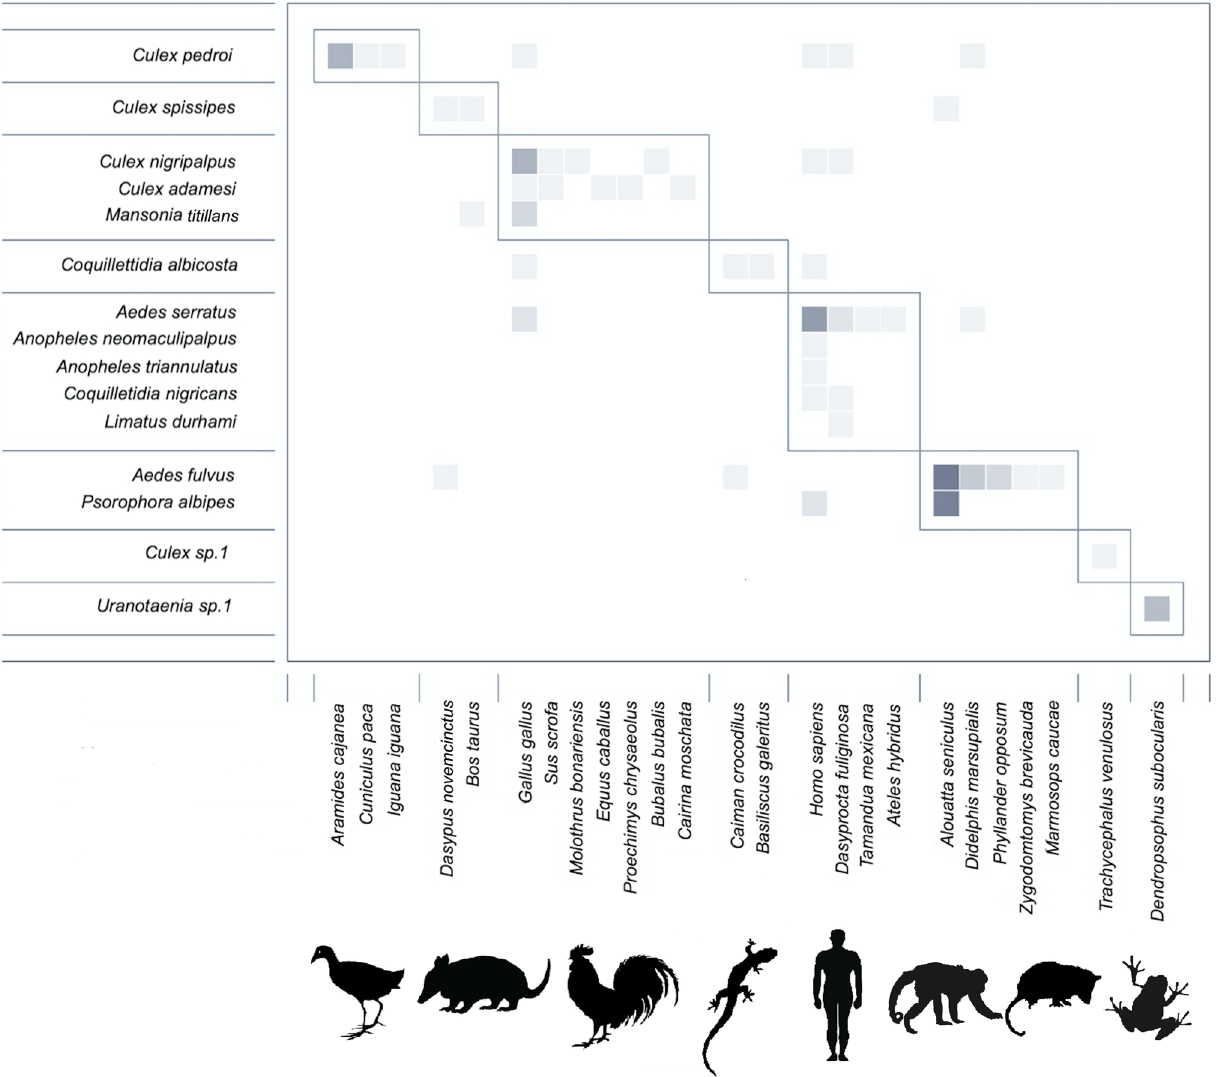
Q max = 0.59). Boxes delineate the eight modules. Darker squares indicate a greater number of interactions detected, and lighter colors fewer interactions detected. The analysis detected eight modules or subsets of mosquito species interacting more frequently with specific subsets of